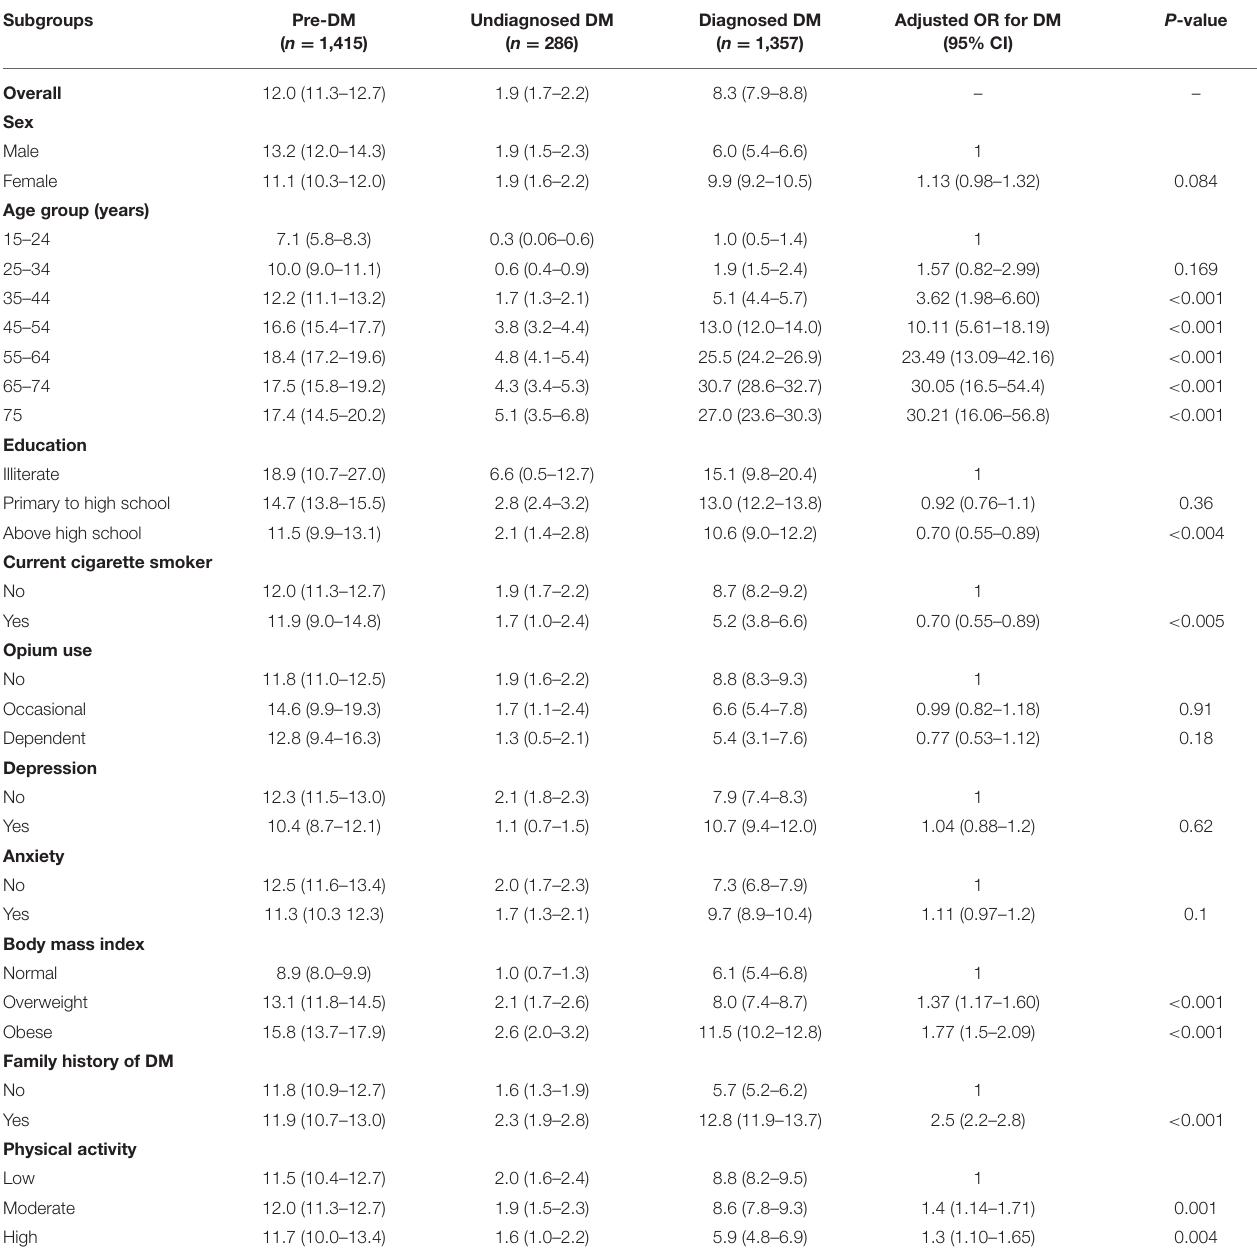
TABLE 1 | The standardized prevalence % (95% confidence interval CI) of pre-diabetes, undiagnosed and diagnosed diabetes, and adjusted odds ratio for different predictors of diabetes mellitus; community-based cohort study (KERCADRS-2nd Phase- N = 9,959), Kerman, Iran 2014–2018. Subgroups